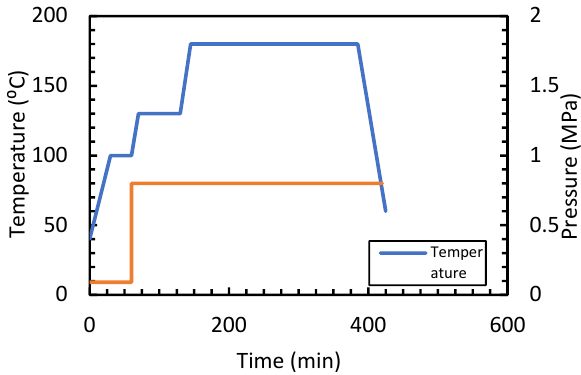
Figure 6. Curing procedure of the composite laminates.